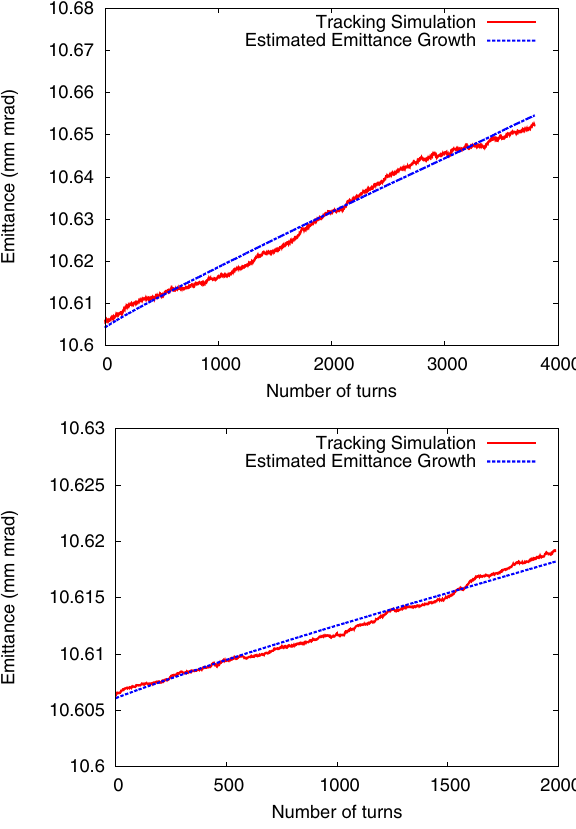
q ffiffiffiffiffiffiffiffiffiffiffiffiffiffi ε 2 ε 2 due to FIG. 4. Evolution of the emittance ε ¼ x þ y 10000 macropar- numerical noise for a simulation with N M ¼ 20000 macroparticles (bottom) for a K-V ticles (top) and N M ¼ beam tracked in the SIS100 lattice. The theory developed in this paper (blue line) predicts the artificial emittance growth in the simulation (red dots). The beam and simulation parameters are given in the